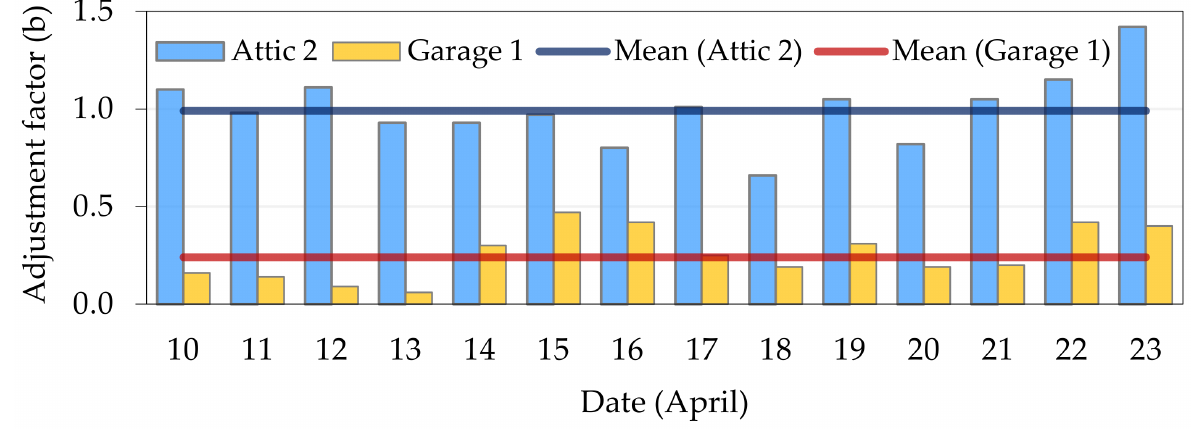
Figure 14. Daily variation of the adjustment factor (b) for Attic 2 and Garage 1.